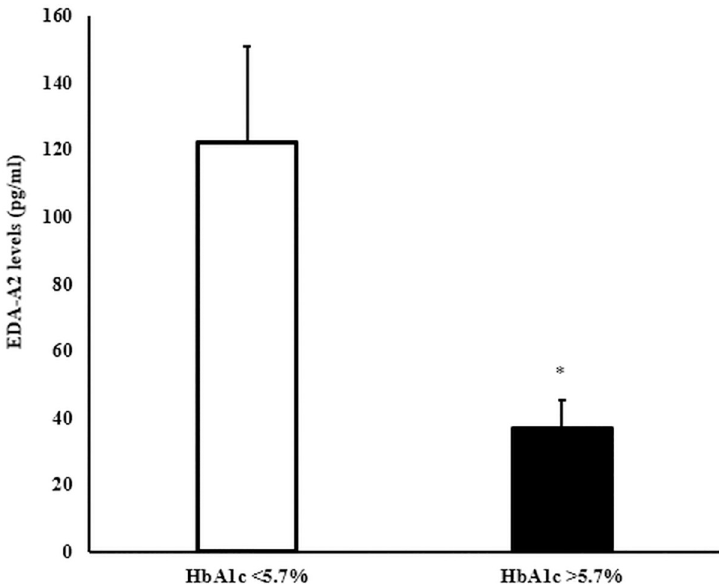
Fig 3. EDA-A2 levels (pg/ml) by HbA1c cutoffs of normal glucose tolerance < 5.7% and prediabetes � 5.7%. Values are mean ± SEM. � p < 0.05.